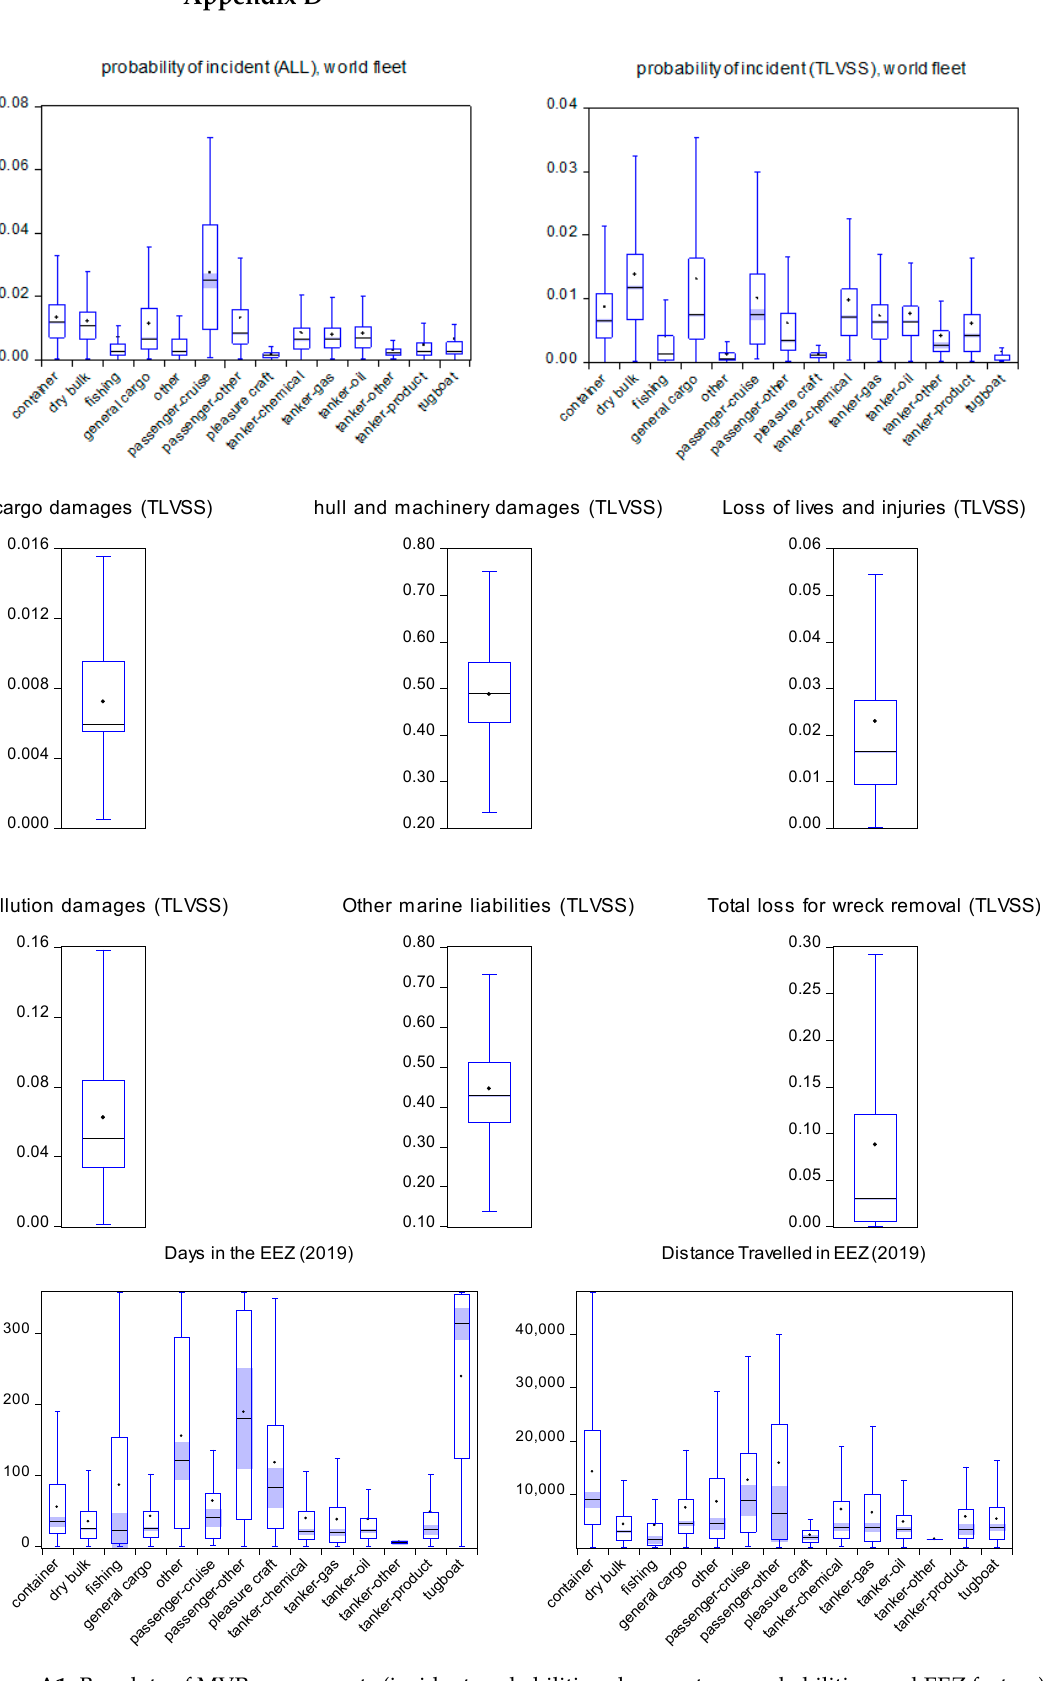
Figure A1. Boxplots of MVR components (incident probabilities, damage type probabilities, and EEZ factors).